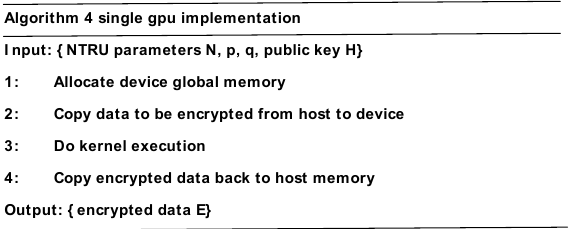
Fig. 4. single gpu implementation